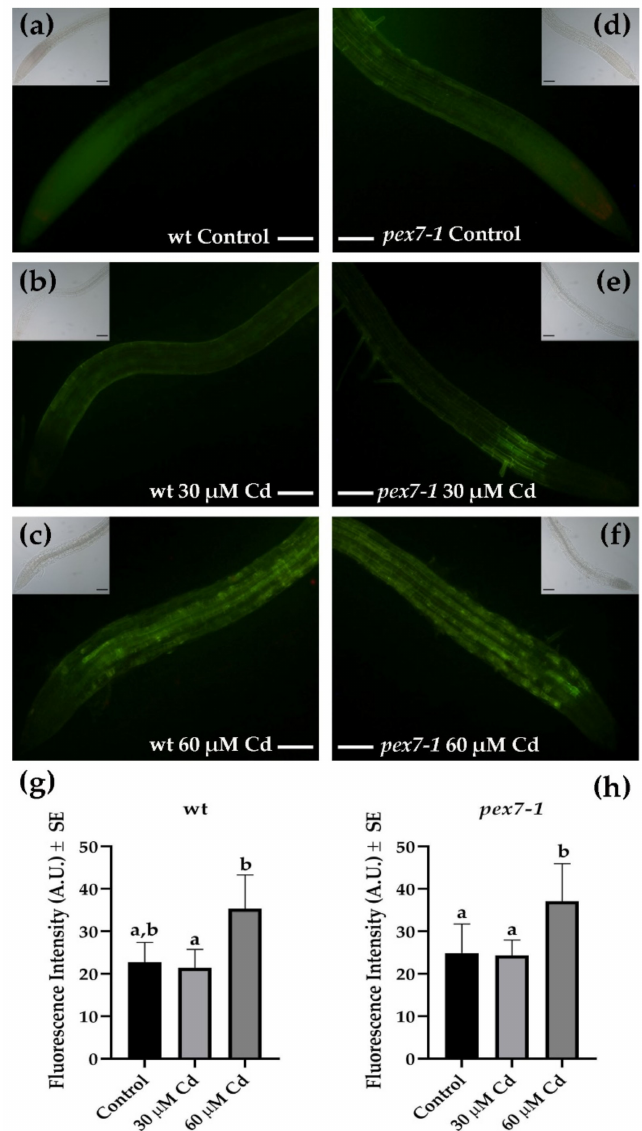
Figure 6. APF epifluorescence analysis showing peroxynitrite (ONOO − ) signal in the wt ( a – c ) and pex7-1 ( d – f ) roots from seedlings grown in the absence (( a , d ) Control) or in the presence of 30 µ M CdSO 4 (30 µ M Cd) ( b , e ) or 60 µ M CdSO 4 (60 µ M Cd) ( c , f ). Insets in ( a – f ) show the same field under white light. ( g , h ) Mean values ( ± SE) from three biological replicates of APF fluorescence intensity measured using ImageJ software (version 1.53c, Wayne Rasband, National Institutes of Health, Bethesda, USA) and expressed in arbitrary units (A.U.s; from 0 to 255). Columns labelled with different letters among treatments show statistical differences for at least p < 0.05 level. Columns labelled with the same letter are not statistically different ( p > 0.05). Bars = 100 µ m. n =